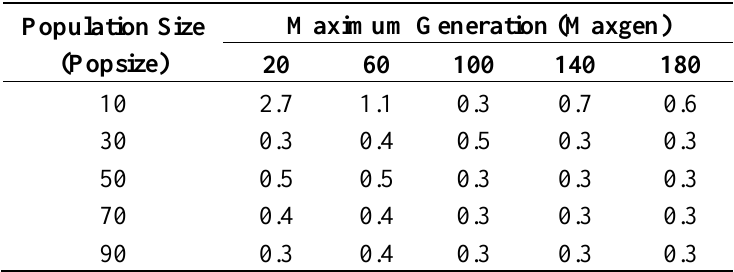
Table 4. MAEs of the retrieved land surface temperatures with different population sizes and maximum generations in the genetic